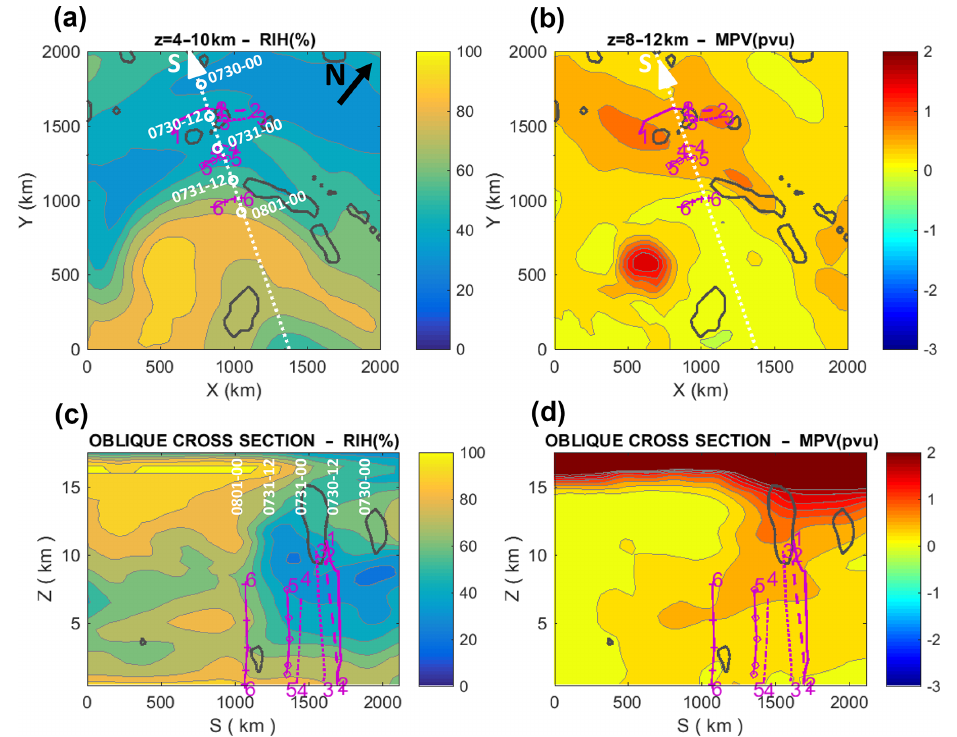
Figure 10. As in Fig. 7, except for the domain shown in Fig. 5b, the period 30 July at 06:00UTC–1 August at 00:00UTC, and six tracks of IAGOS aircraft during take-offs and landings on 30–31 July in the vicinity of Severe Tropical Storm Nida.